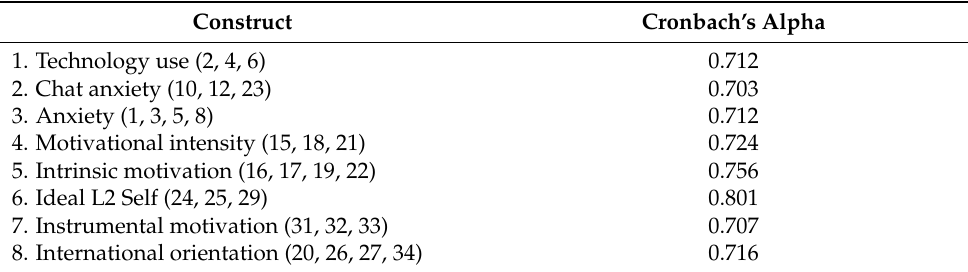
Table A1. Internal reliability of language motivation and anxiety constructs.